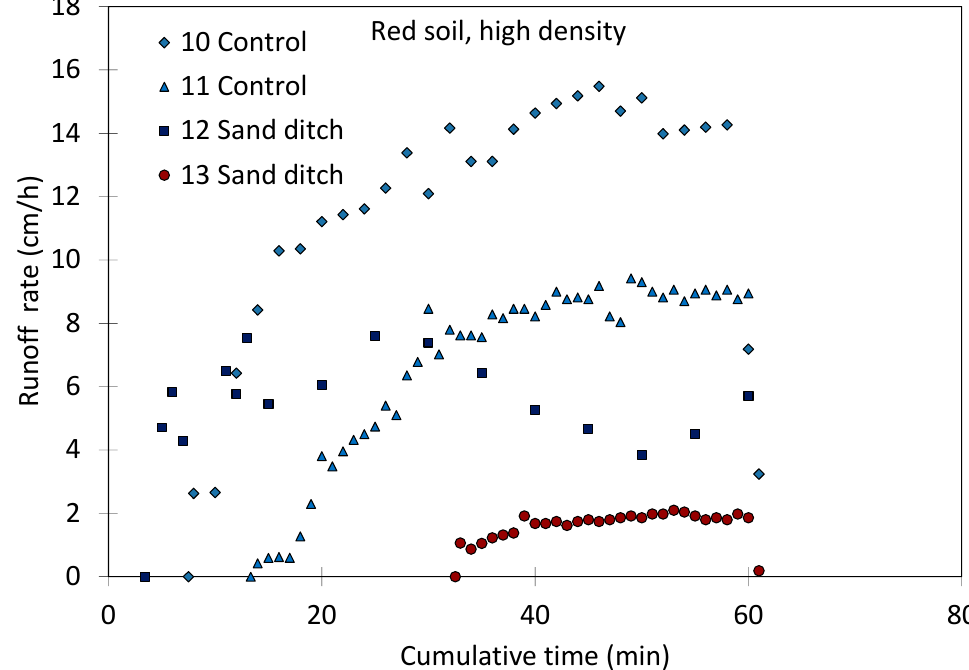
Figure 5. Runo ff rates measured at the runo ff outlet of soil boxes for compacted high-density clay Figure 5. Runoff rates measured at the runoff outlet of soil boxes for compacted high-density clay soil.